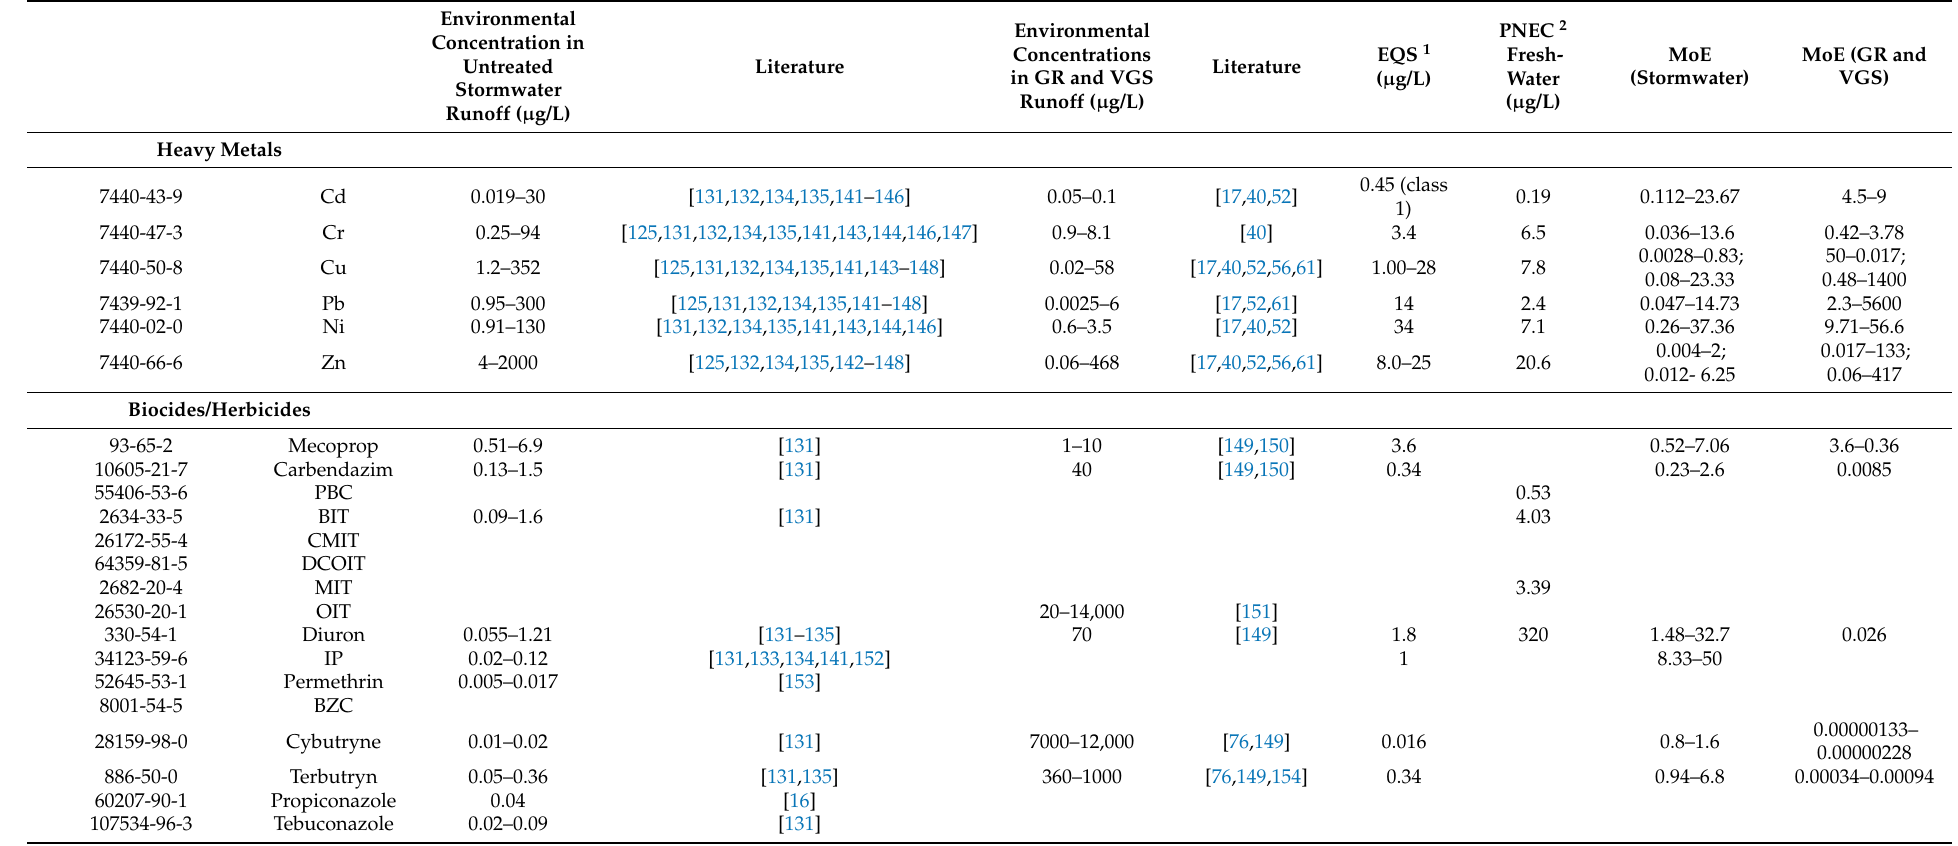
Table 5. Comparison of environmental concentrations in runoff from stormwater and GRs and VGSs to the EQS (PNEC) and calculation of MoE. Environmental Concentration